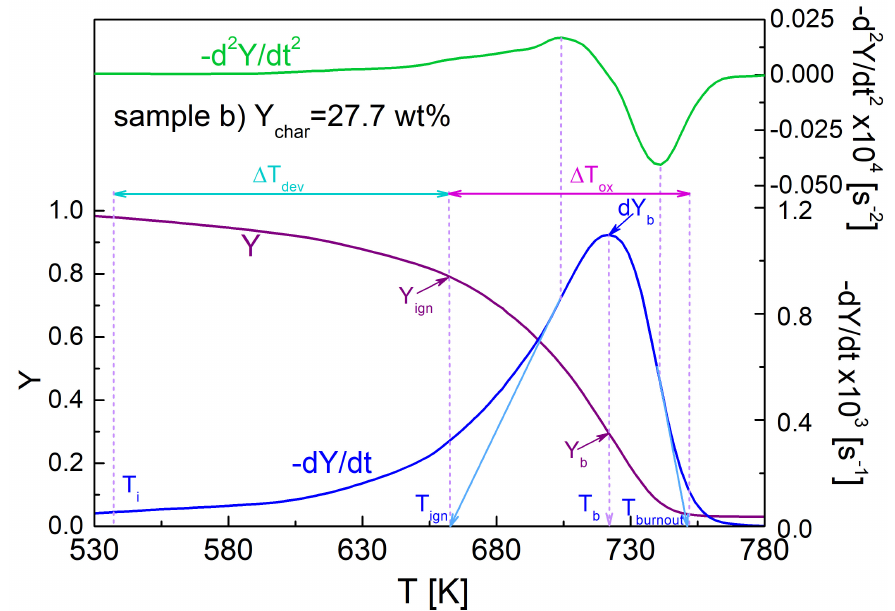
Figure 2. Mass fraction, Y, and first, − dY/dt, and second, − d 2 Y/dt 2 , time derivatives of the mass fraction, showing the thermogravimetric parameters: peak rate, dY b , and corresponding temperature, T b , and mass fraction, Y b . The temperatures for the beginning and completion of char oxidation, T ign and T burnout , respectively, and corresponding temperature interval, ∆ T ox = T burnout − T ign , the char mass fraction, Y ign , in correspondence of T ign , the initial temperature for devolatilization, T i , and the temperature range for devolatilization, ∆ T dev = T ign − T i , are also shown.